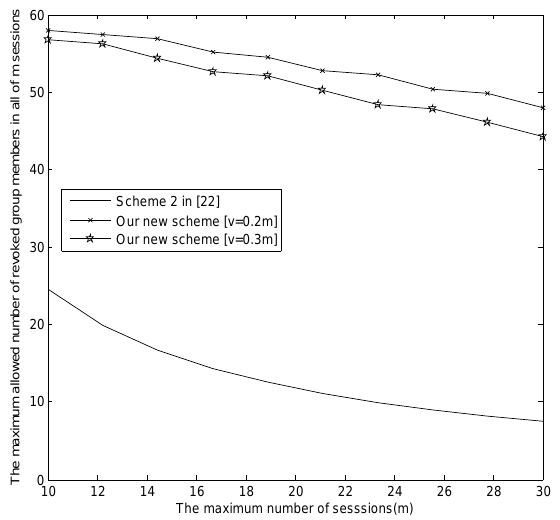
Figure 7. The trade-off between m and | R m | max as the size of the broadcast message is 4